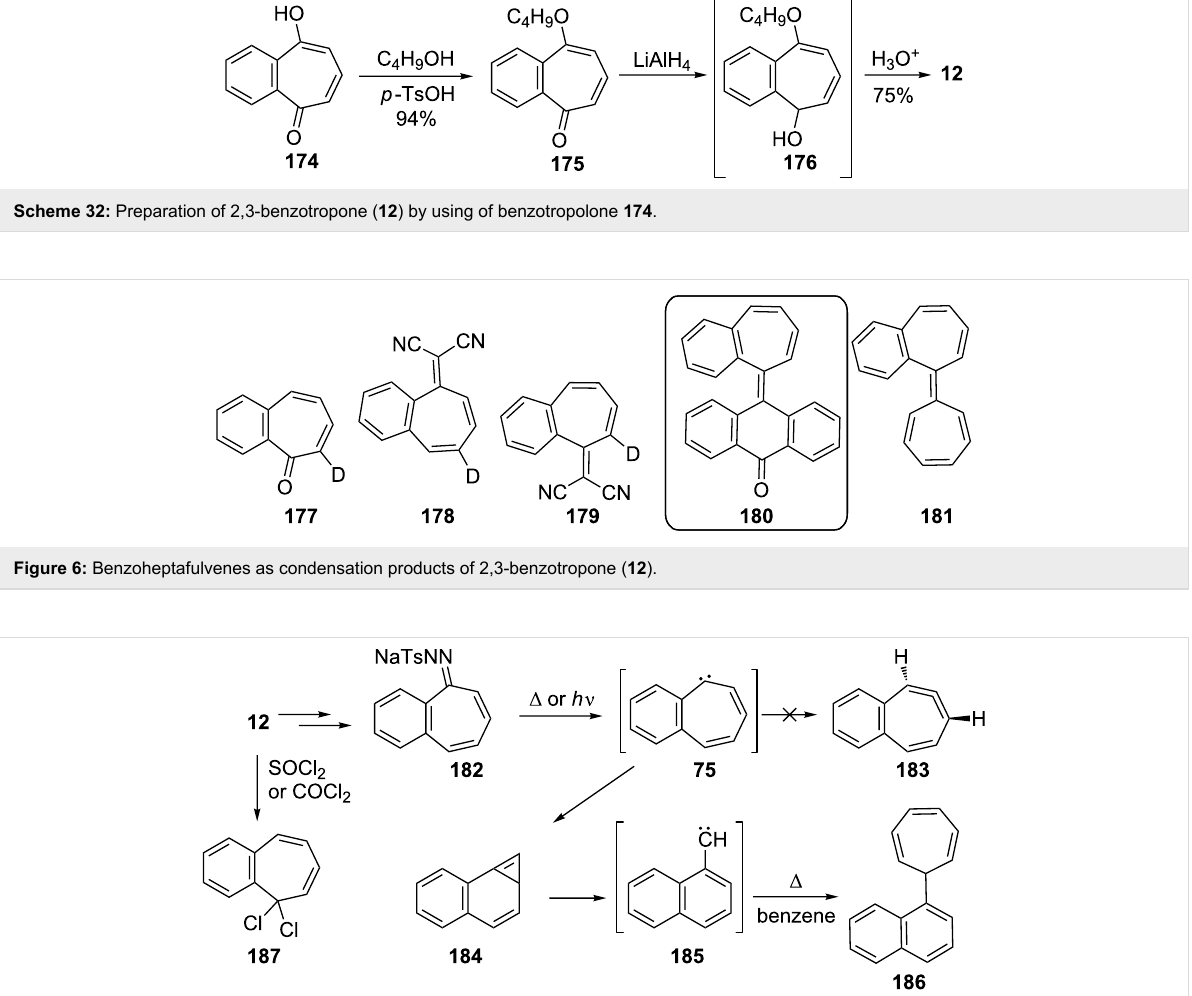
Scheme 33: Conversion of 2,3-benzotropone ( 12 ) to tosylhydrazone salt 182 and gem -dichloride 187